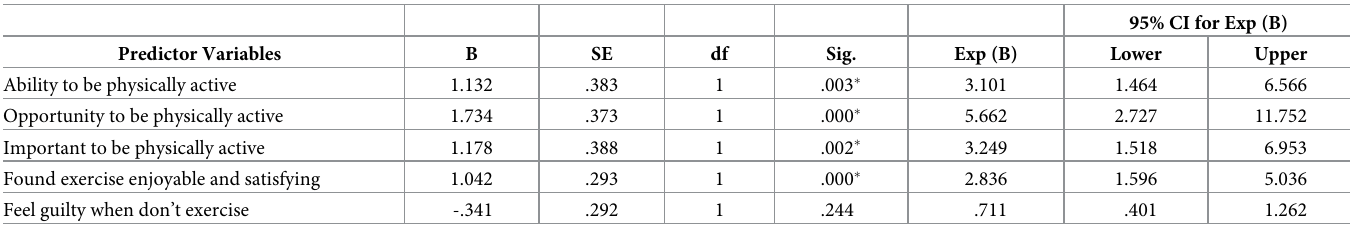
Table 5. Agreement with COM-B statements as predictors of meeting the PA guidelines during